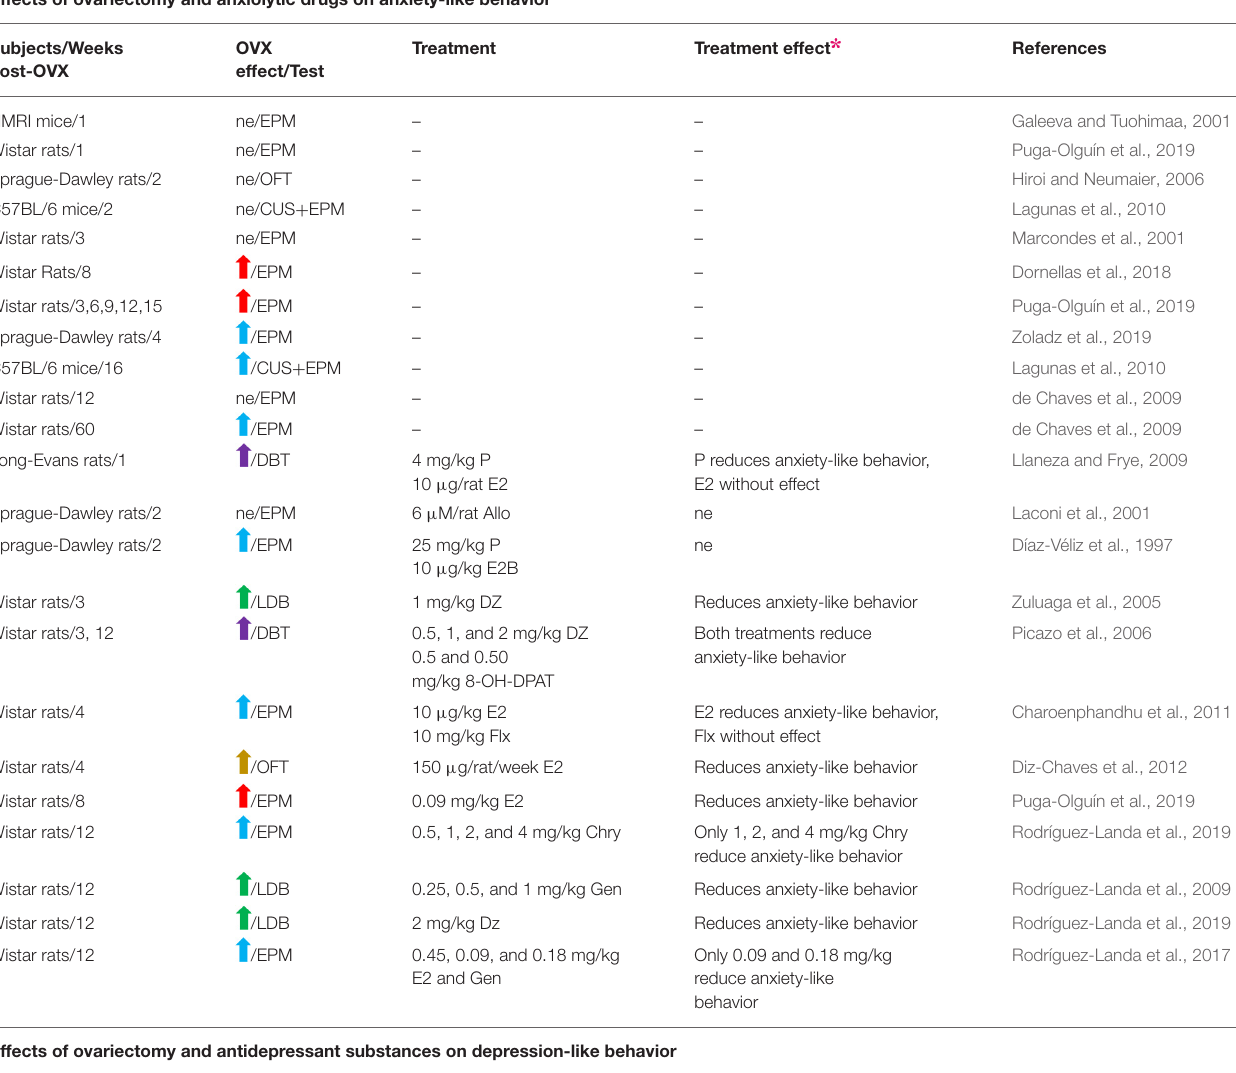
TABLE 1 | Effects of timing post-ovariectomy and some pharmacological treatments on anxiety- and depression-like behaviors in mice and rats. Effects of ovariectomy and anxiolytic drugs on anxiety-like